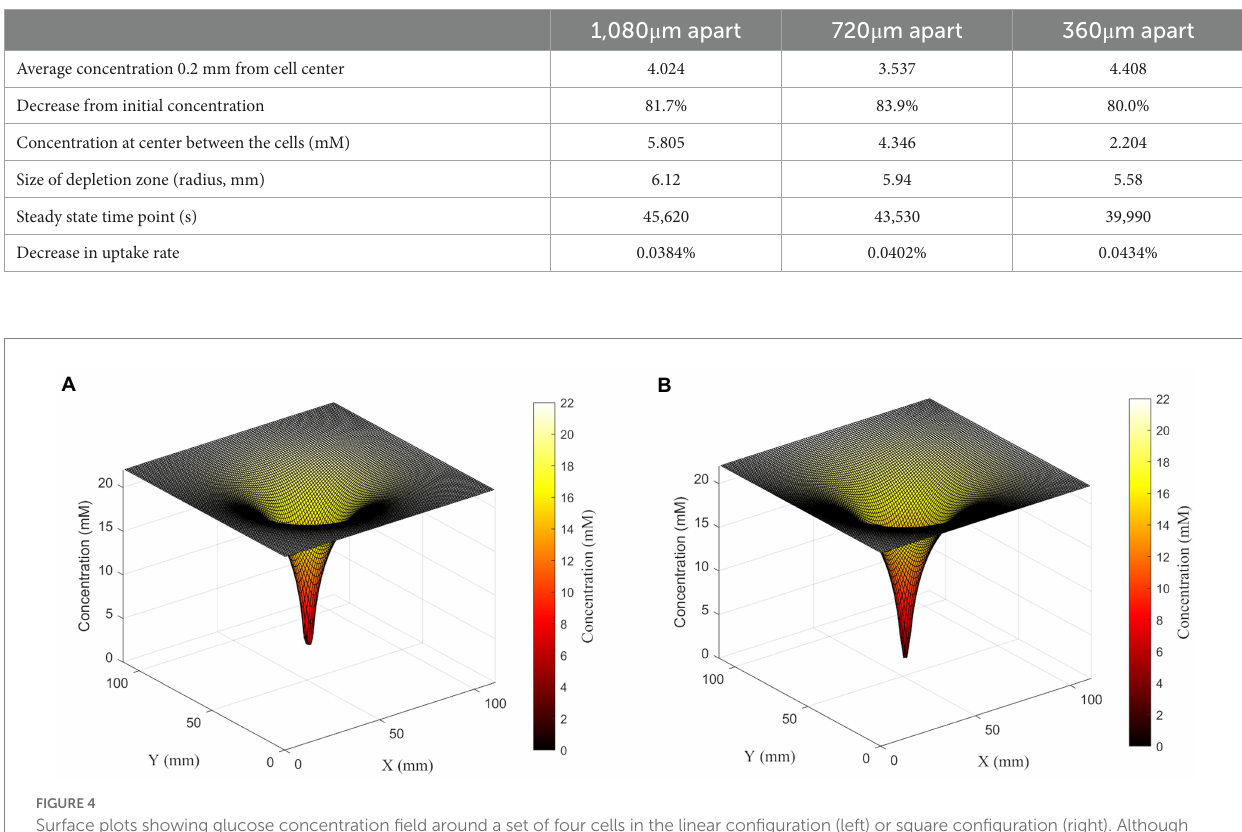
TABLE 1 Results from FDM calculation of glucose concentrations surrounding two non-motile Escherichia coli cells in M9 medium in diffusion-limited microgravity suspension culture, at varying distances from each